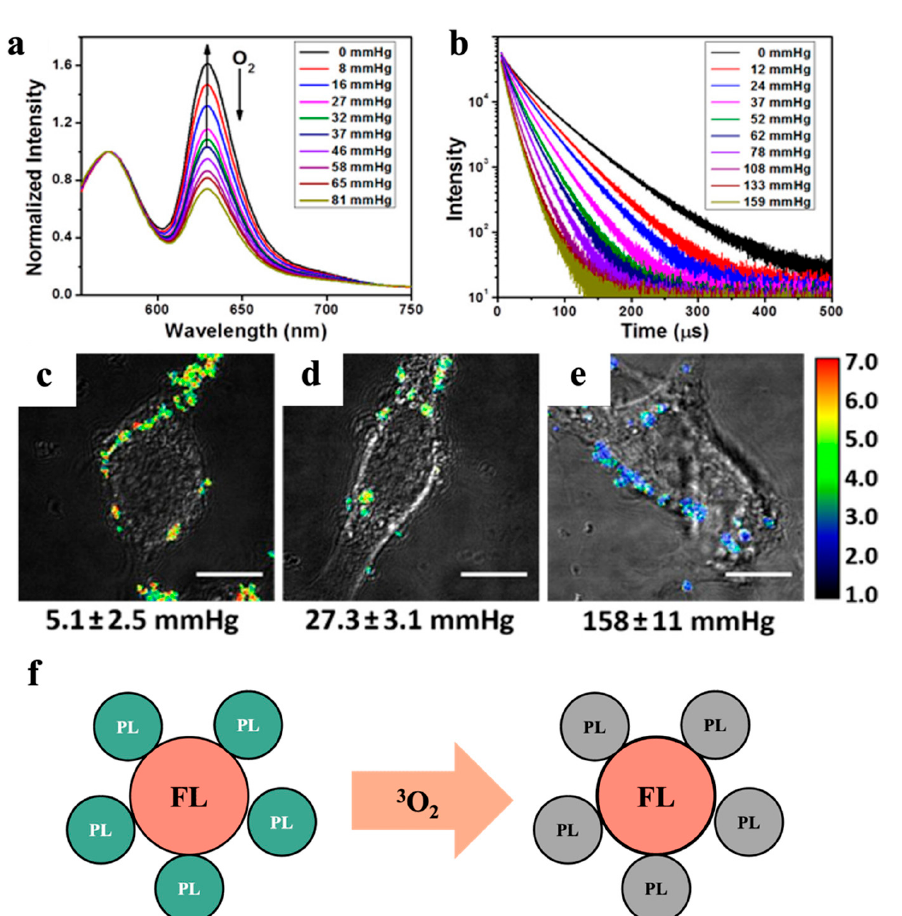
Figure 4. Oxygen sensing based on the phosphorescence-to-fluorescence ratio of R-UiO-1. ( a ) Emission spectra ( λ ex = 514 nm) and ( b ) phosphorescent decays ( λ ex = 405 nm) of R-UiO-1 in HBSS buffer under varied oxygen partial pressures. Ratiometric luminescence imaging ( λ ex = 514 nm) of CT26 cells after incubation with R-UiO-2 under ( c ) hypoxia, ( d ) normoxia, and ( e ) aerated conditions. Scale bar: 10 μ m. ( f ) Schematics of fluorescence (Fl)–phosphorescence (Ph) dual emission centers, with Ph center quenched (Qu) in response to oxygen [79]. Copyright 2016, American Chemical Society.